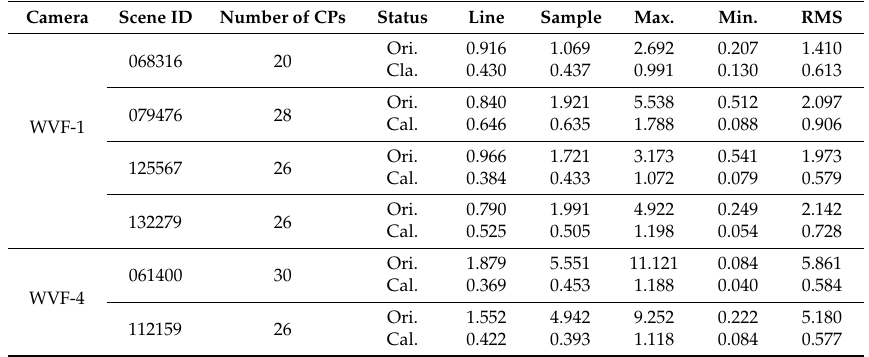
Table 5. Orientation accuracy before and after calibration for validation images (units: pixels).